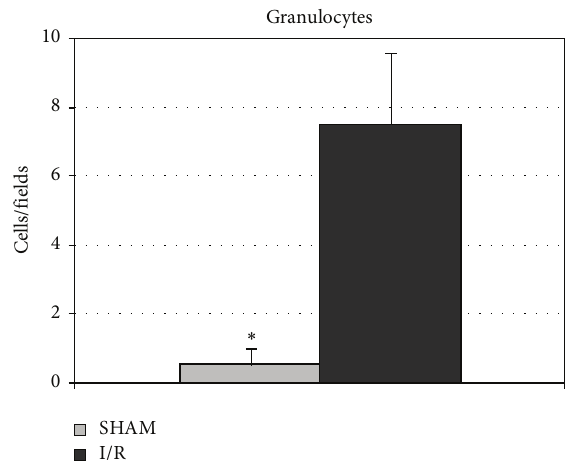
Figure 5: Changes of lung granulocytes in response to hepatic I/R injury. Lung samples were obtained from sham-operated rats, not submitted to hepatic I/R, and from rats whose hepatic lobes were submitted to 30 min of ischemia and hence reperfused for 60 min. The number of granulocytes was calculated per microscopic field. ∗ 𝑃 < 0.05 . Data are shown as mean values ±